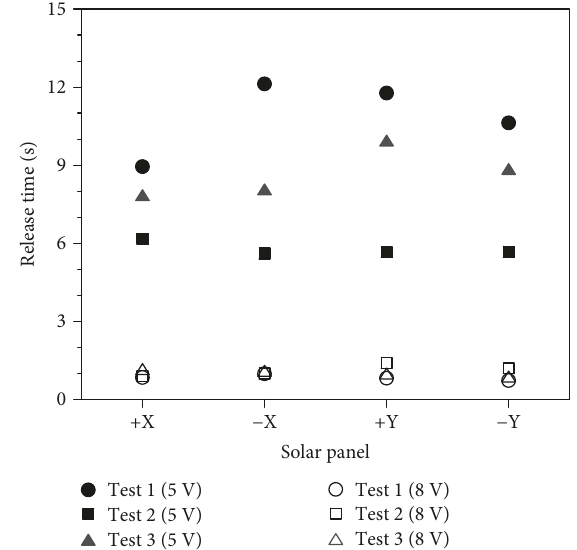
Figure 10: Release time of each solar panel when the input voltages of 5V and 8V are applied on the